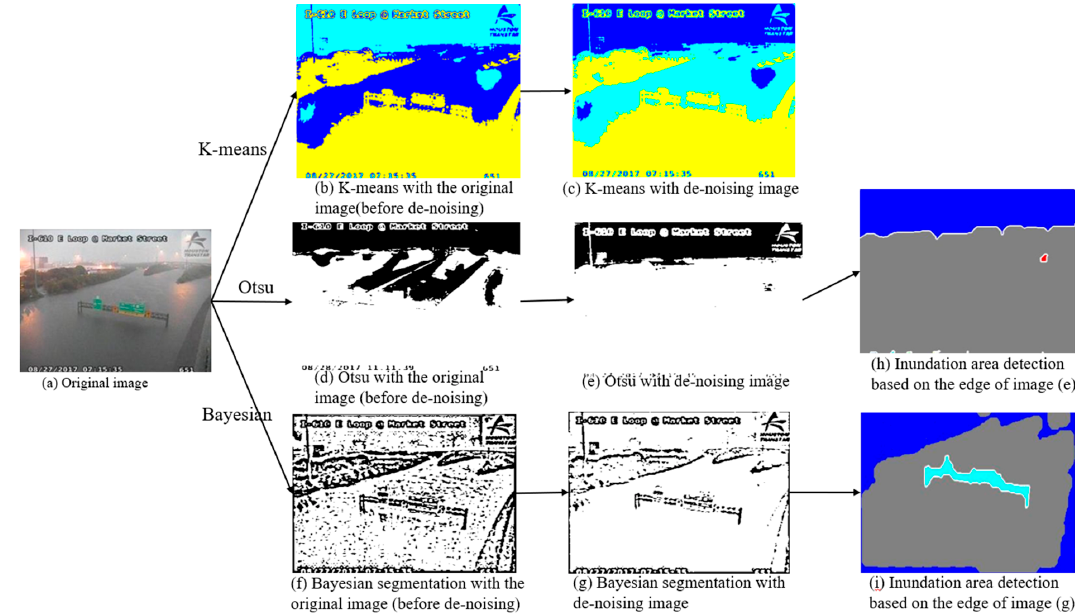
Figure 8. The comparison of before and after image de-noising filtering using different image segmentation methods. The result ( b ) and ( c ) presents using the k-means; the result ( d ) and ( e ) presents using the Otsu; and the result ( f ) and ( g ) presents using the Bayesian of the noisy image and the de-noised image, separately. The results ( h ) and ( i ) indicates the water area surrounded by the edge of Figure 8e,g, separately.